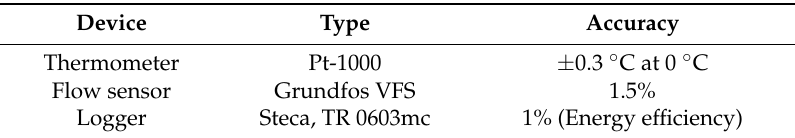
Table 2. Description of measurement equipment.